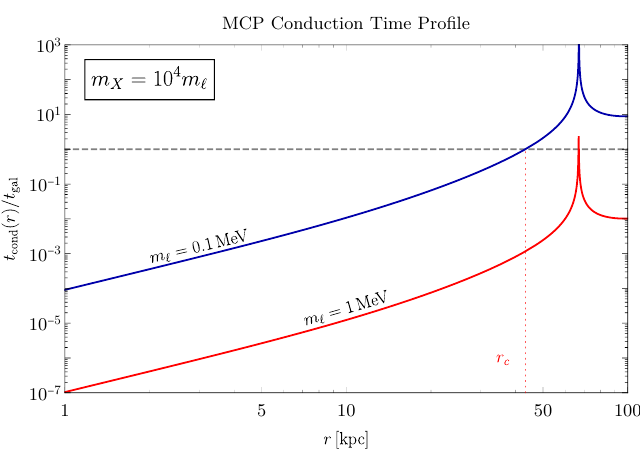
Figure 3 . The conduction timescale t cond defined in eq. (4.8) across the halo normalized by the galaxy age t gal . The point at which t cond diverges is an artefact of an arbitrary choice in eq. (4.8): it is where ∂T / ∂t vanishes for the initial adiabatic halo. As the halo evolves the temperature profile changes with it, ∂T / ∂t will no longer be zero and heat will begin to conduct